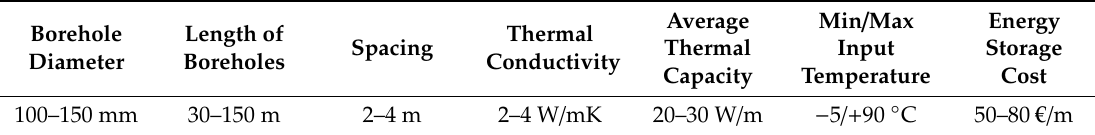
Table 6. Typical BTES technology parameters